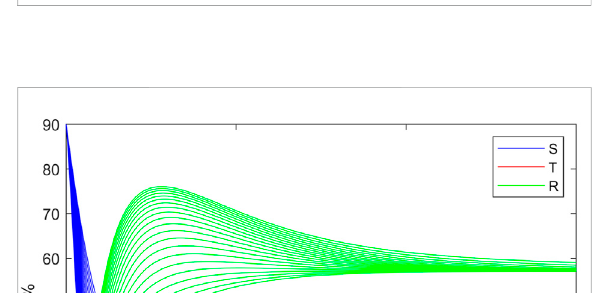
FIGURE 2 Variation in the numbers of I when R 0 < 1.